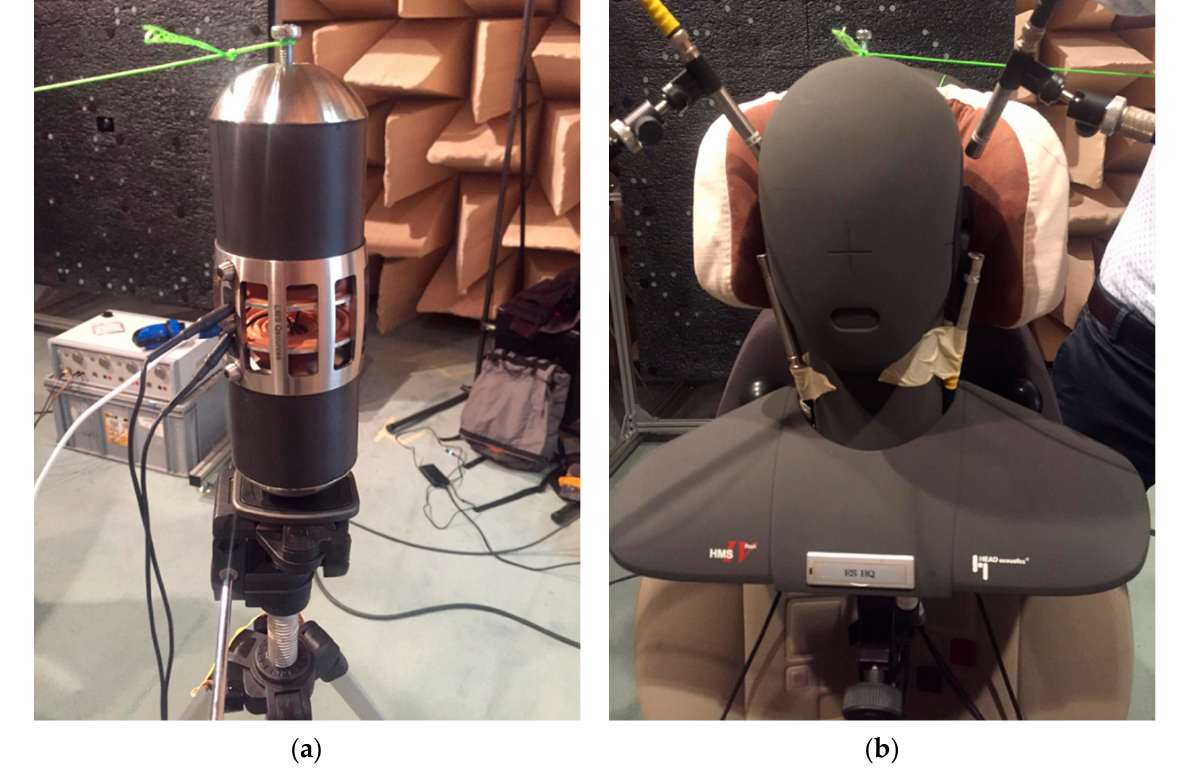
Figure 7. ( a ) Calibrated monopolar volume velocity source (Simcenter Qsource) and ( b ) binaural head (HEAD Acoustics HMS) adopted for the tests.